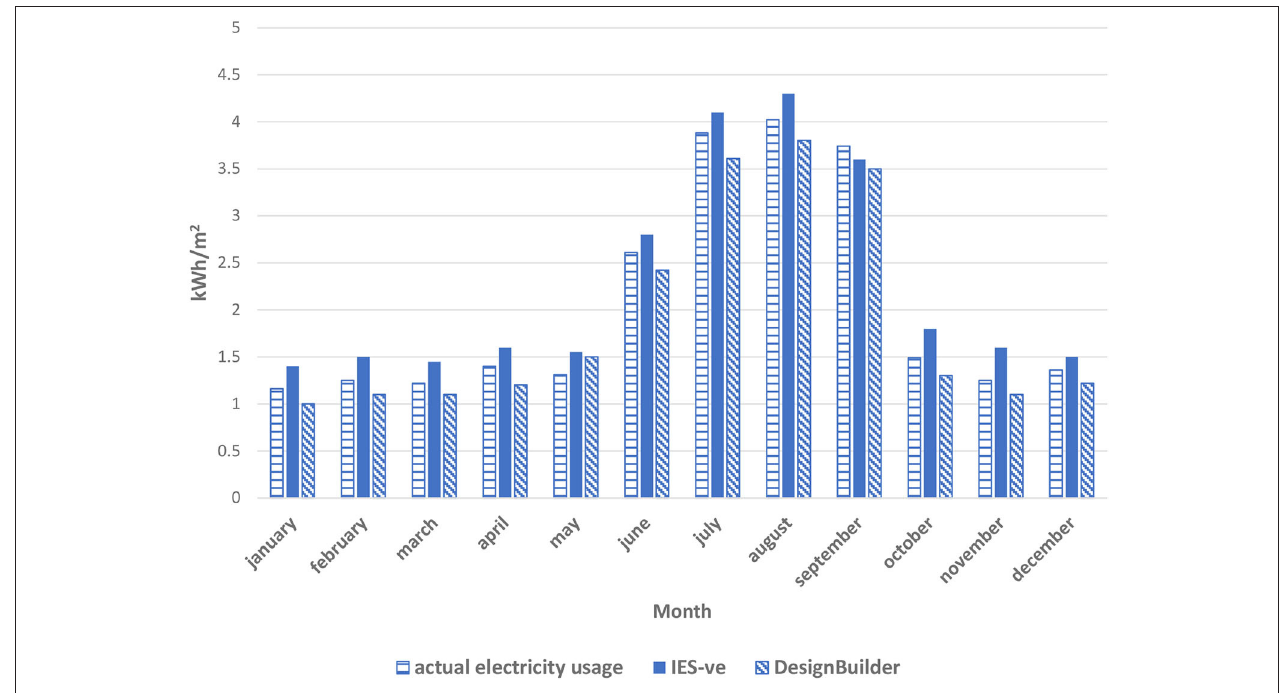
FIGURE 17 | Simulated and actual monthly electricity